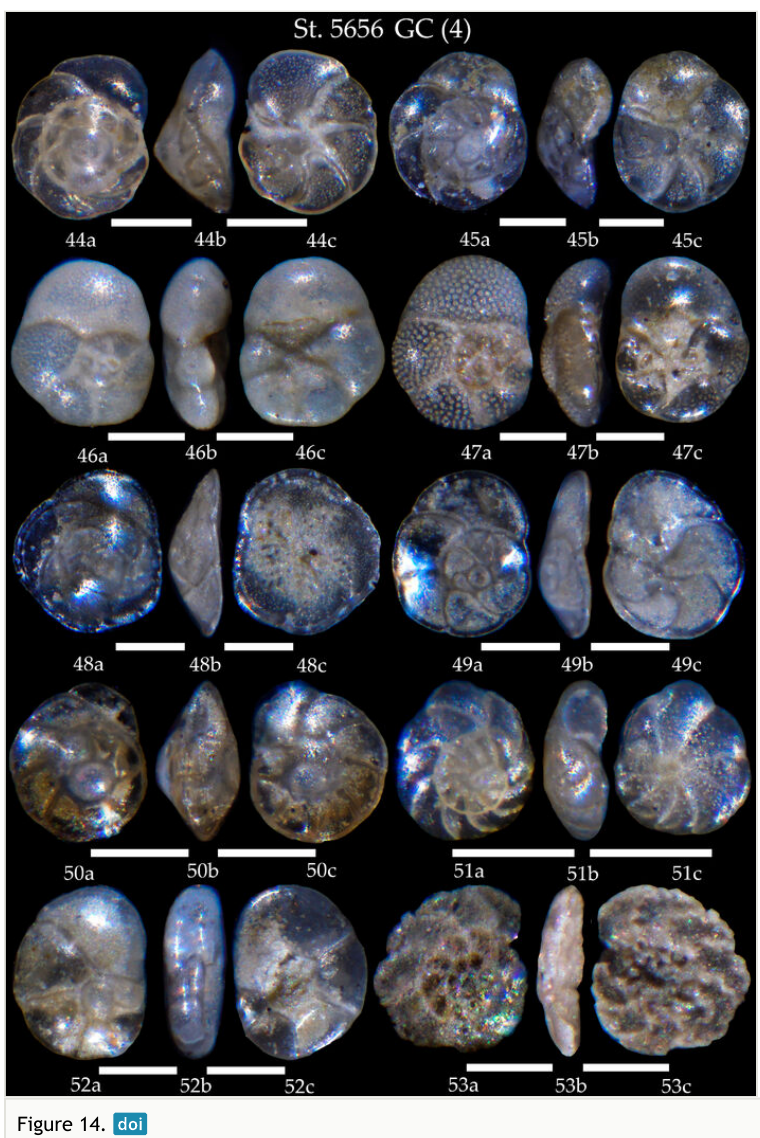
Figure 14. Station 5656 GC (continued). 44,45 Rosalina vilardeboana , a spiral view, b apertural view, c umbilical view; 46 Rosalina globularis , a spiral view, b apertural view, c umbilical view; 47 Rosalina bradyi , a spiral view, b apertural view, c umbilical view; 48 Rosalina opercularis , a spiral view, b apertural view, c umbilical view; 49 Rosalina bertheloti , a spiral view, b apertural view, c umbilical view; 50 Rosalina araucana , a spiral view, b apertural view, c umbilical view; 51 Rosalina sp., a spiral view, b apertural view, c umbilical view; 52 Lamarckina haliotidea , a spiral view, b apertural view, c umbilical view; 53 Discorbis sp., a spiral view, b apertural view, c umbilical view. Scale 100